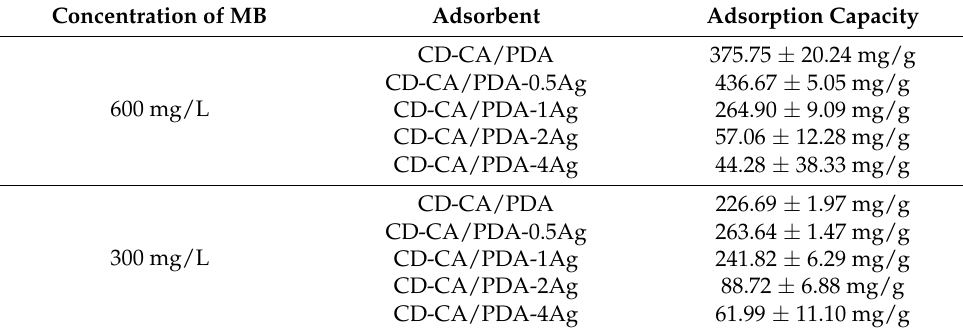
Figure 7. The adsorption property of CD-CA/PDA-xAg at the initial MB concentration of 600 mg/L ( a ) and 300 mg/L ( b ); adsorption kinetics of CD-CA/PDA-xAg adsorption of MB when the initial concentration is ( c ) 600 mg/L and ( d ) 300 mg/L fitted by pseudo-second order model. Table 1. The adsorption capacity of CD-CA/PDA-xAg when time is 10 min of the initial MB concentration of 600 mg/L and 300 mg/L.